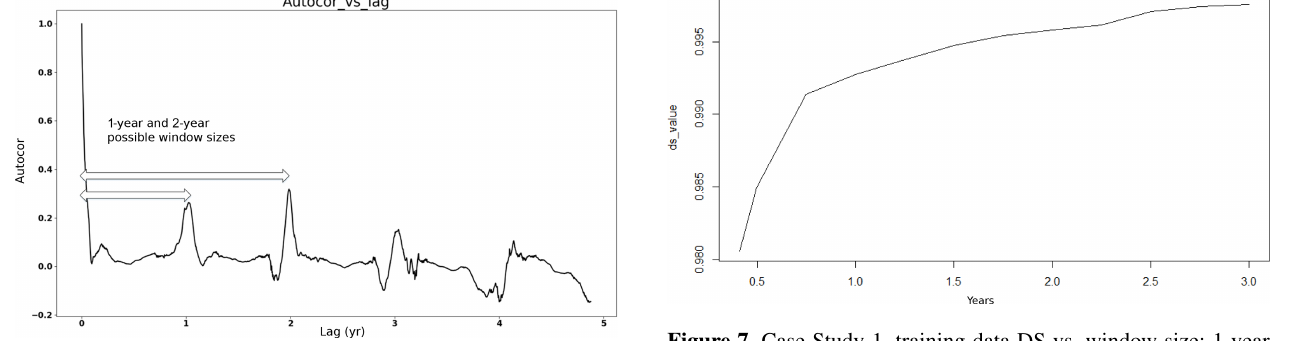
Figure 6. Case Study 1, training data autocorrelation values vs. lag days: the data pattern lengths can be 1 year or 2 years because these are the distances between the start point and peaks in the training data.